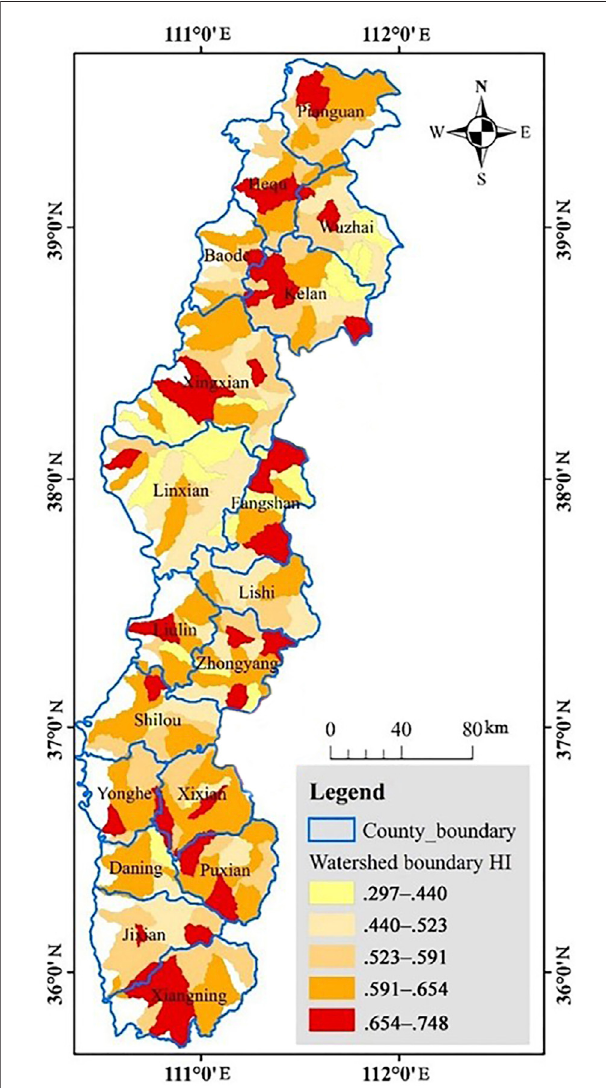
FIGURE 7 | Map of the spatial differentiation of the Hypsometric integral (HI) of the watershed boundary.